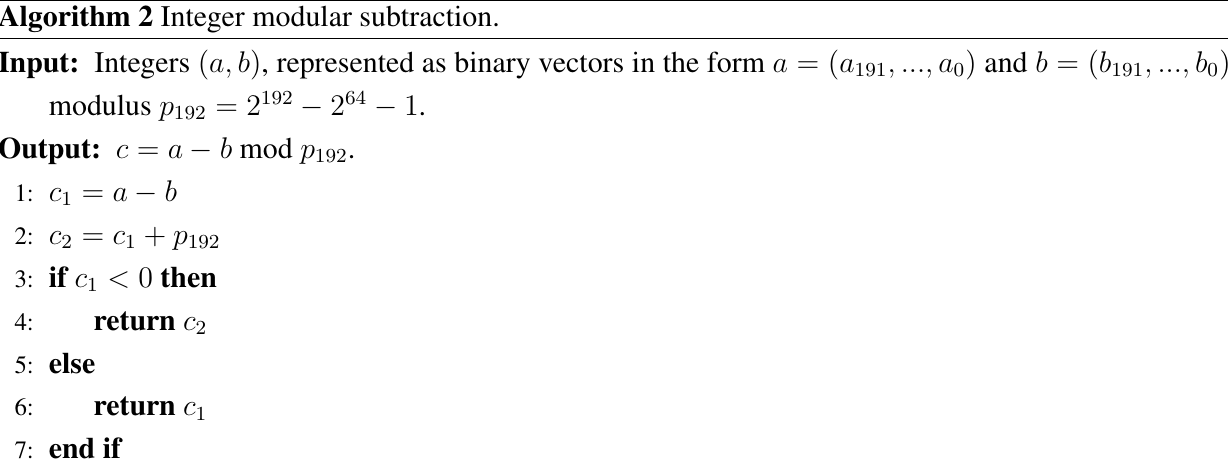
Algorithm 2 Integer modular